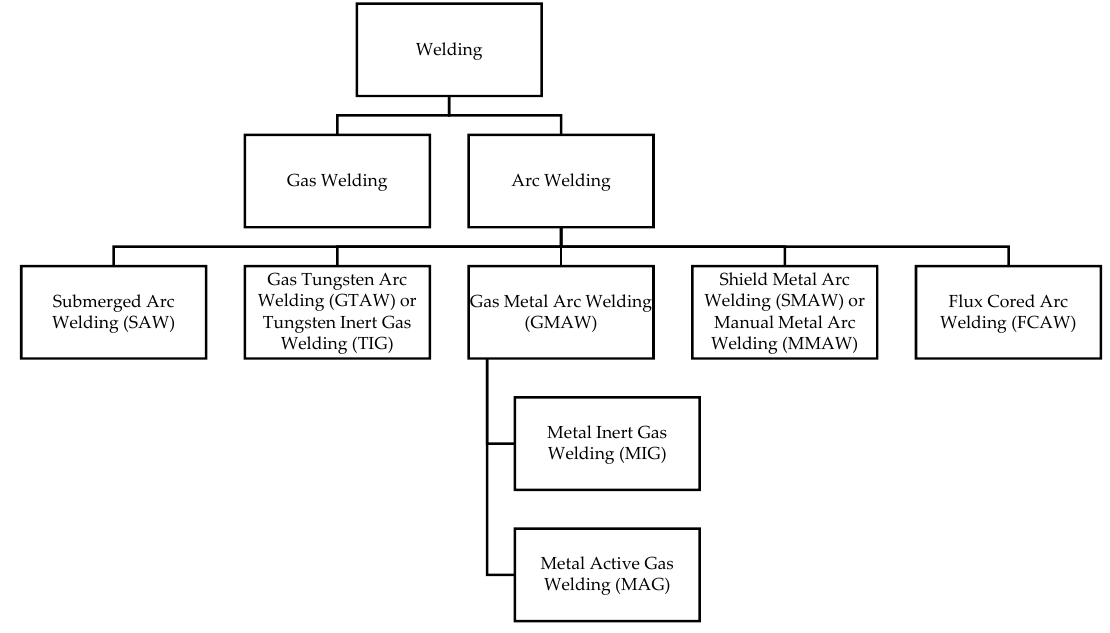
Figure 1. Schematic of welding methods.